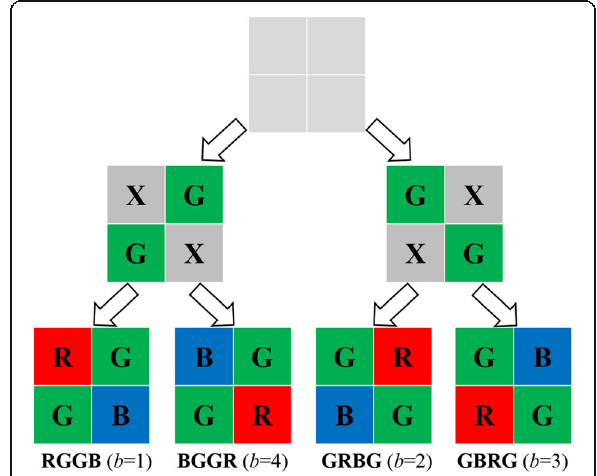
Fig. 3 Two-step Bayer CFA pattern identification process